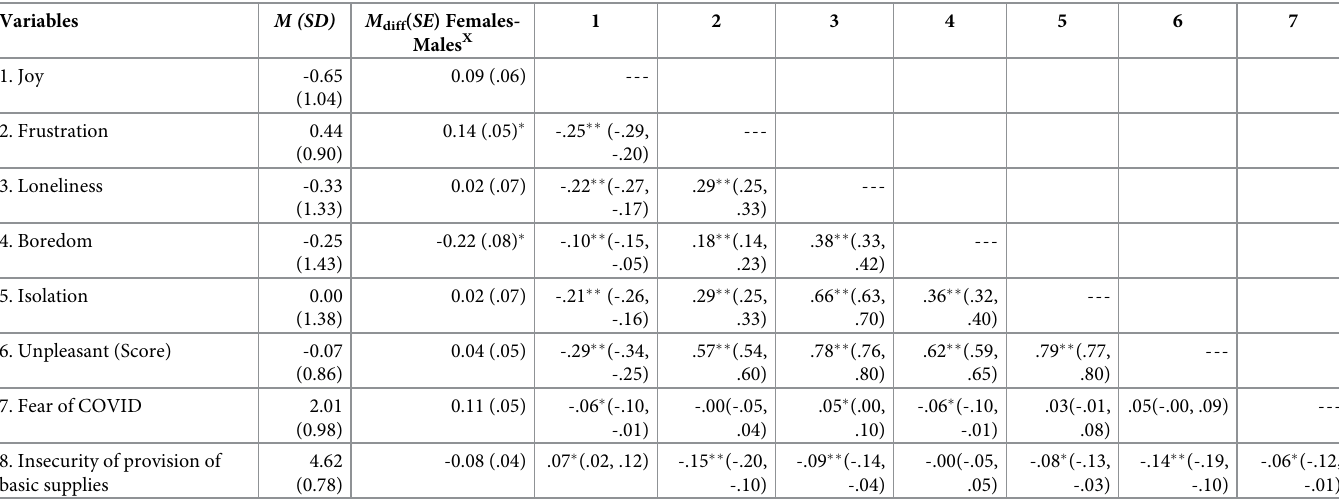
Table 2. Correlations between changes in unpleasant emotions and joy. Variables